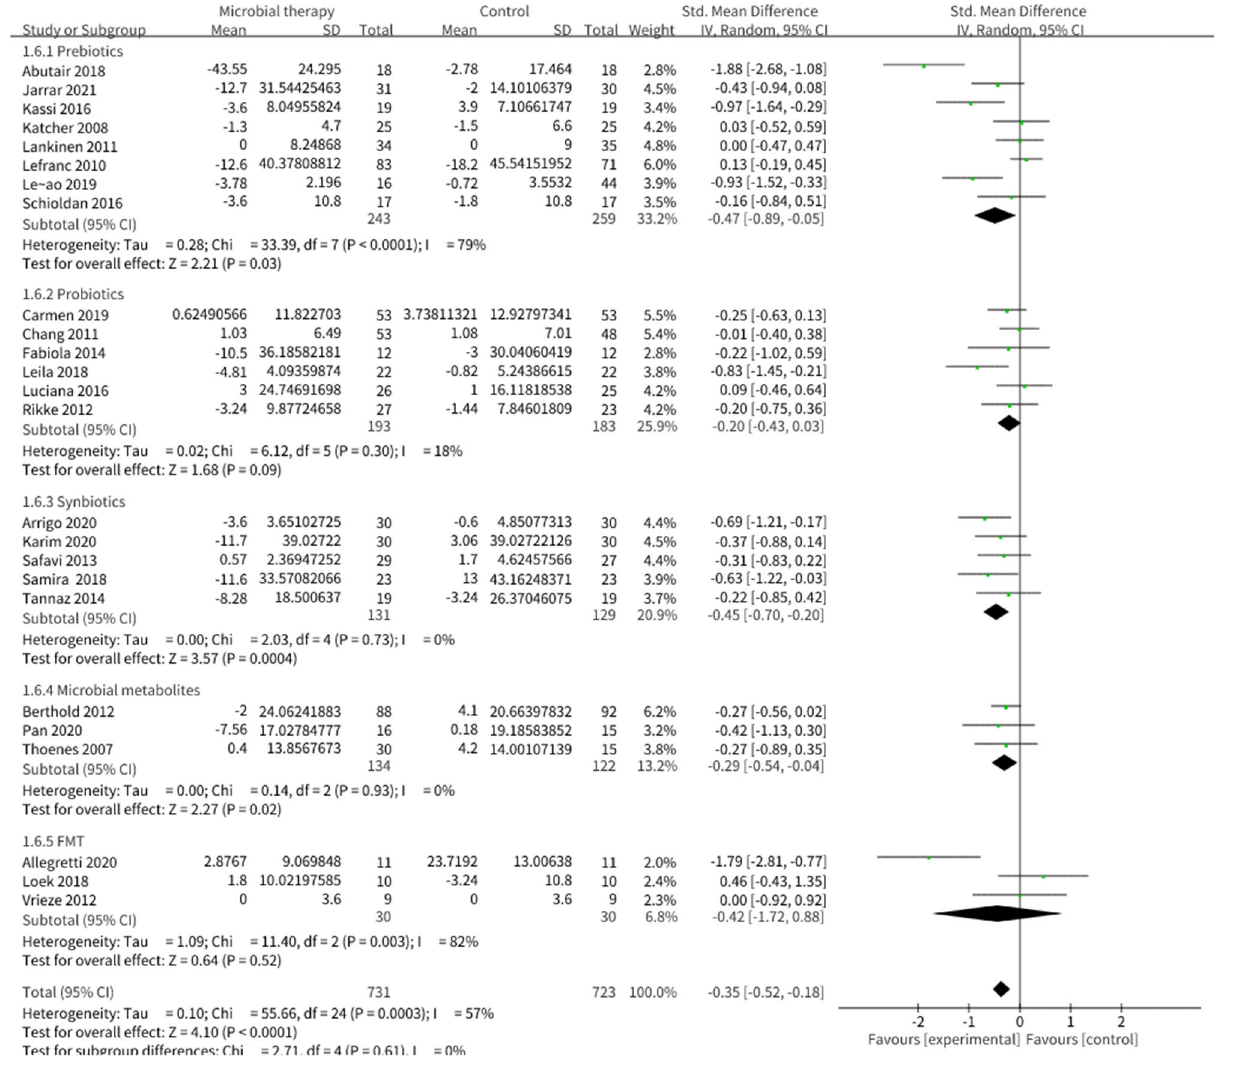
FIGURE 2 | Comparison of standard mean difference (SMD) of fasting blood glucose (FBG) control between intervention groups and control groups Tau 2 = 0.10, I 2 = 57%, 95% CI − 0.52 to − 0.18, Z = 4.10, p < 0.0001. Significant difference was shown in